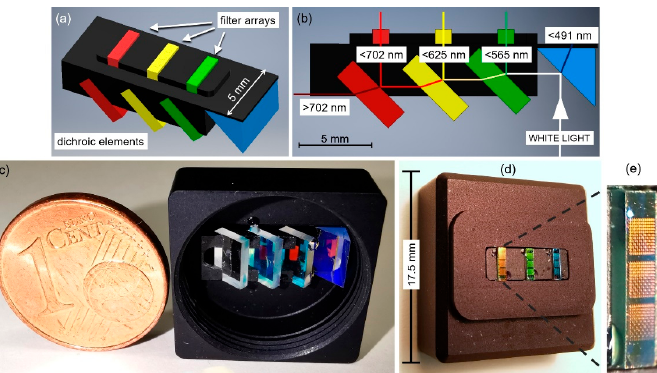
Figure 8. Efficiency enhanced filter-array-based module demonstrating the proof-of-concept of spectral preselection. ( a ) 3D representation of the setup showing the used FP filter arrays and di- chroic beam splitters. ( b ) Cross-section of the 3D model indicating transmission and reflection ranges of the beam splitters. ( c , d ) Photographs of the module integrated in a mounting for the adaption to a CCD camera. The open front side of the module is shown in ( c ) with a 1 Euro cent coin for size comparison. The backside of the module showing the filter arrays is shown in ( d ), and a magnified image ( e ) of one substrate carrying filter arrays. Reproduced with permission of [82] © The Optical Society, 2020.